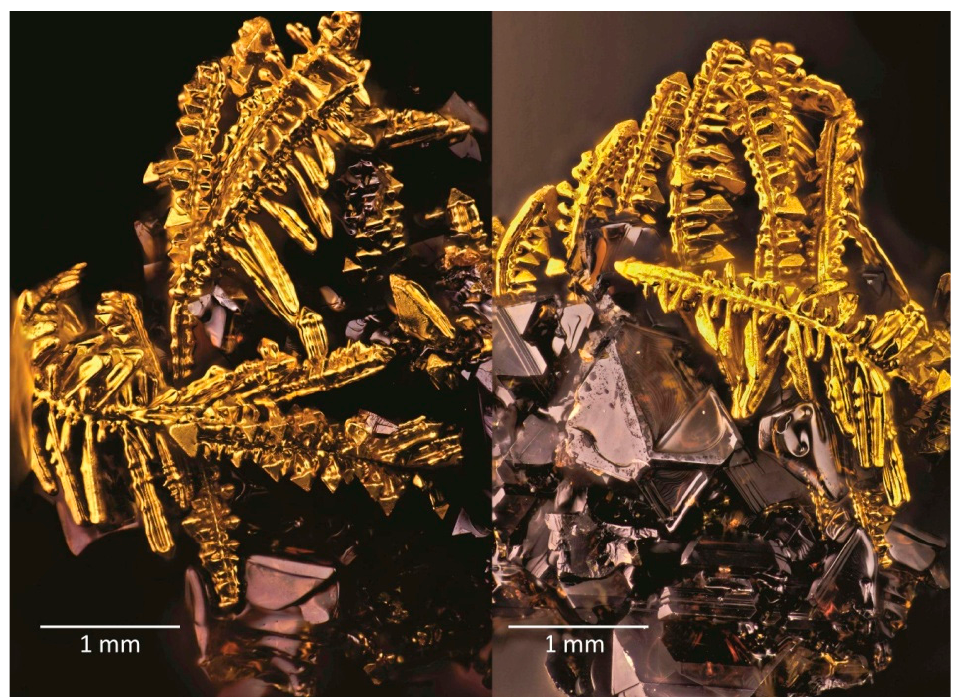
Figure 39. Relation between the Fe and Au concentrations in the synthetic crystals of sphalerite. Crystals were synthesised at ~850 °C at the hot and ~750 °C at the cold end of the ampoule. Grey lines show the concentration of Fe (wt%, EPMA) for some samples.